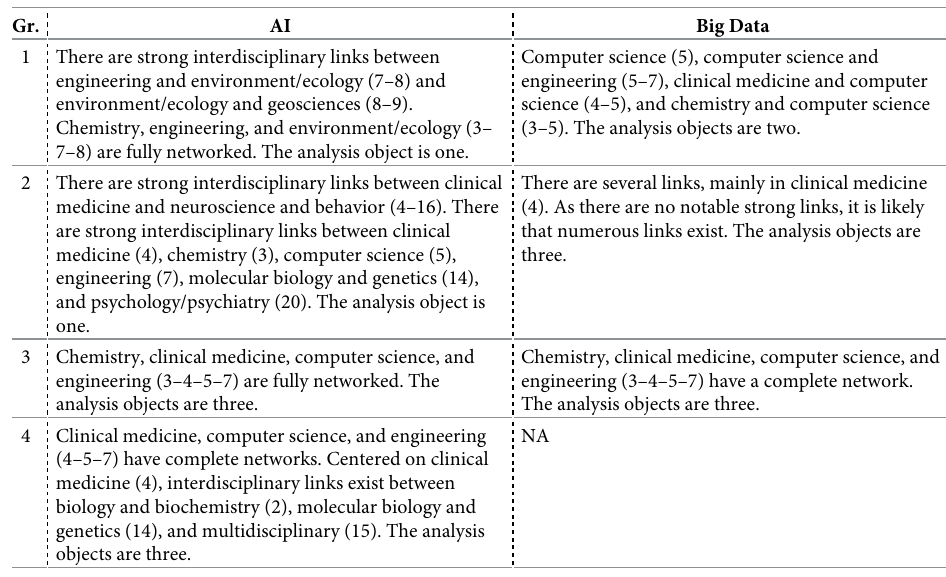
Table 6. Characteristics of each artificial intelligence and big data